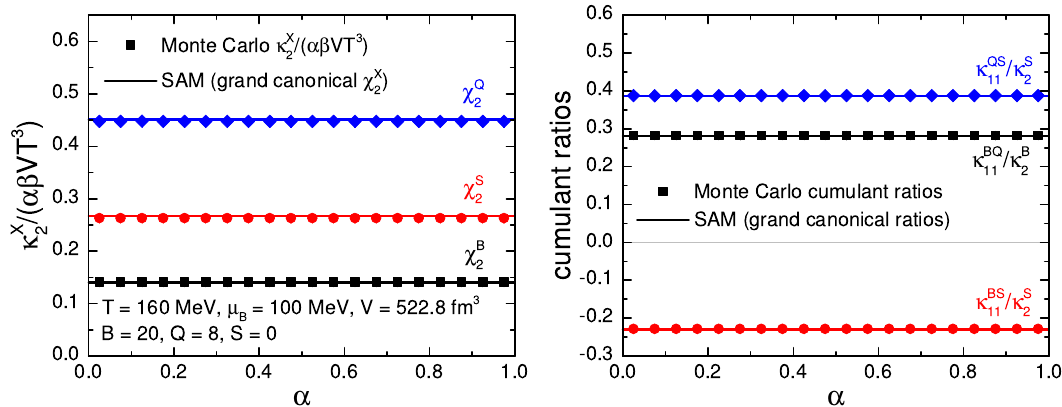
Figure 1 . Dependence of combinations of second order cumulants of conserved charges on the acceptance fraction (cid:11) , as calculated in the hadron resonance gas model using canonical ensemble Monte Carlo sampler (symbols) and analytically in the framework of the subensemble acceptance method (lines). The Monte Carlo calculation contains 10 8 events. Left panel: Diagonal cumulants of net-baryon (black), net-charge (blue), and net-strangeness (red) numbers scaled by a factor (cid:11)(cid:12)V T 3 , yielding the grand-canonical susceptibilities in the SAM [eq. (2.40)]. Here (cid:12) (cid:17) 1 (cid:0) (cid:11) . Right panel: O(cid:11)-diagonal to diagonal conserved charge cumulant ratios (cid:20) BQ (cid:20) BS =(cid:20) S (red). 11 2 characterizes the asymmetry of a distribution around the mean value. The signs of the skewness of QCD conserved charges are thought to be sensitive probes of the QCD phase structure [61]. The SAM predicts that the skewness (cid:20) X pendent of acceptance and coincides with the skewness (cid:31) X canonical